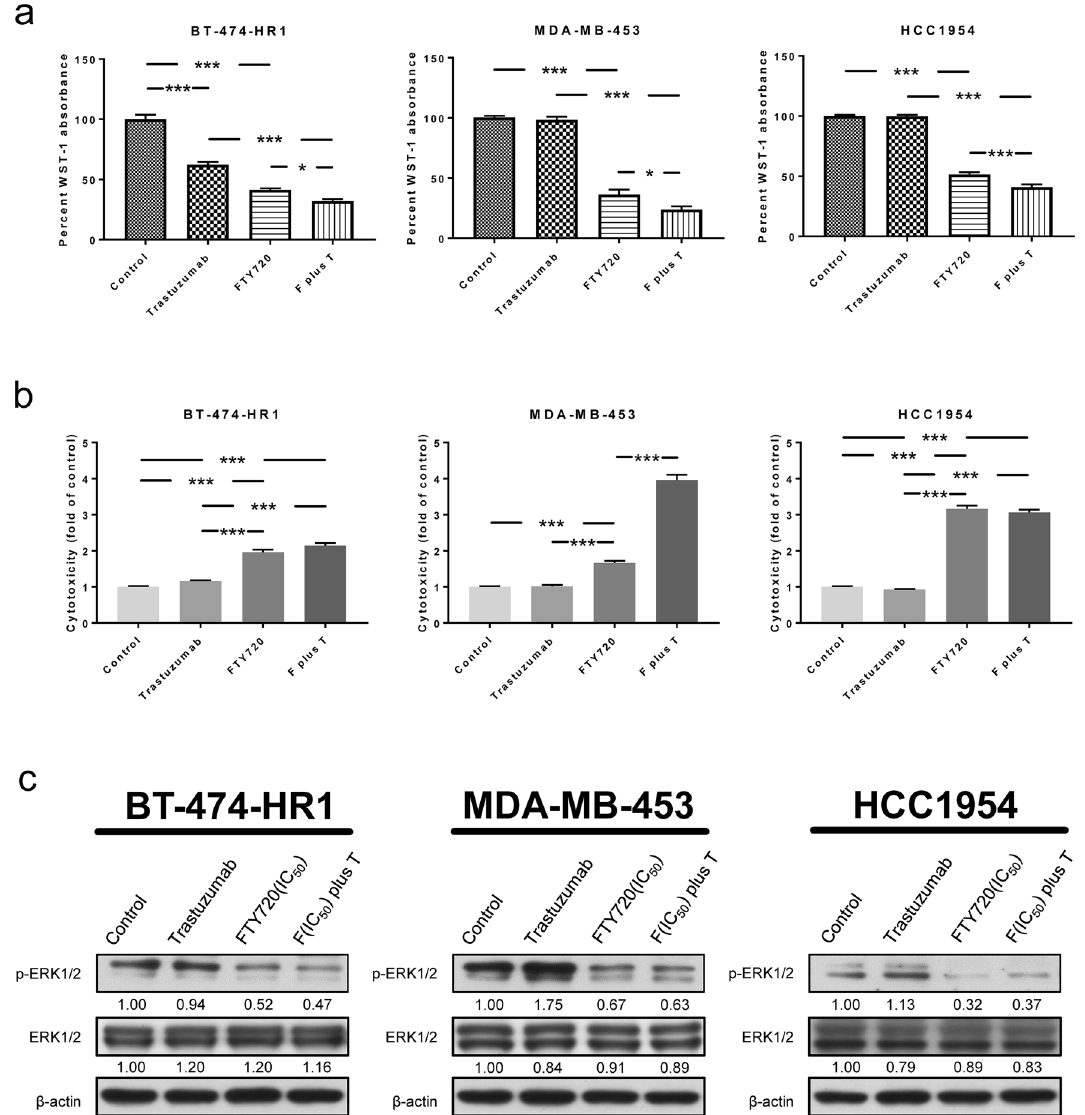
Figure 6. Effects of FTY720 in breast cancer cell lines, alone or in combination with trastuzumab. ( a ) The three cell lines were treated with DMSO, trastuzumab, FTY720, or FTY720 plus trastuzumab. The percentage of WST-1 absorbance was measured 72 h after treatment. ( b ) Cytotoxicity was determined using LDH ‐ cytotoxicity assay kits 72 h after treatment. The cytotoxicity index was calculated, whereas the value of the control group treated with DMSO was adjusted to 1. ( c ) Lysates were collected and analyzed for phospho-ERK1/2, ERK1/2, and beta-actin 24 h after treatment. Equal loading of proteins was verified using beta-actin. Numbers under each blot indicate the intensity of the blot relative to the control. The concentration of trastuzumab used in all cell lines was 2 μg/mL. The concentrations of FTY720 were 7.5, 7.5, and 10 μM for BT-474-HR1, MDA-MB-453, and HCC1954, respectively. Regarding antiproliferative and cytotoxic effects, results were presented as mean ± SEM, and expresses were repeated at least three times. P value: * P < 0.05, ** P < 0.01, and *** P < 0.001. F plus T: FTY720 plus